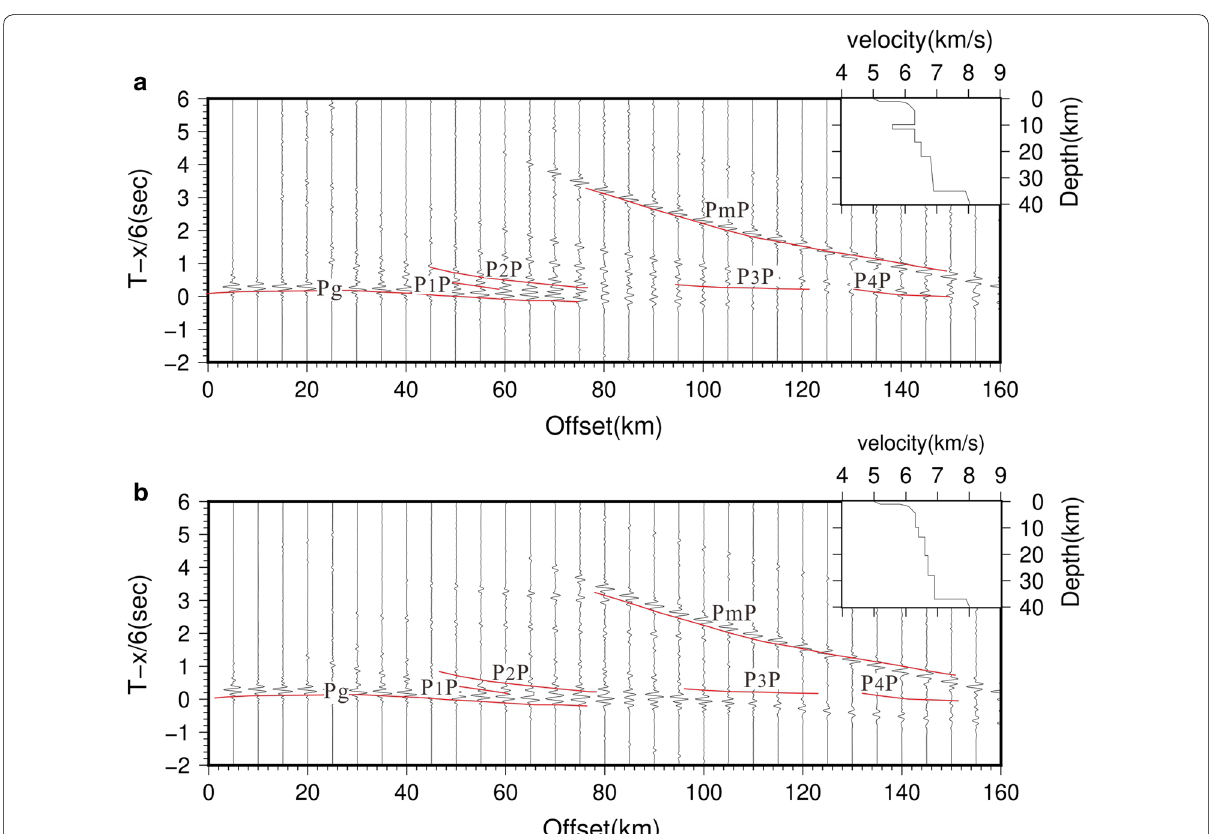
Fig. 4 Synthetic seismogram for the record section of SP1 (Fig. 3a). The red line indicates the picked traveltime in Fig. 3a. a The synthetic data of the model with a LVZ of 5.7 km/s at about depth 10 km. b The synthetic data of the model without the LVZ. These two seismograms indicate that the model without LVZ cannot generate the strong reflected phases P2P at about offset 60 km shown in Fig.